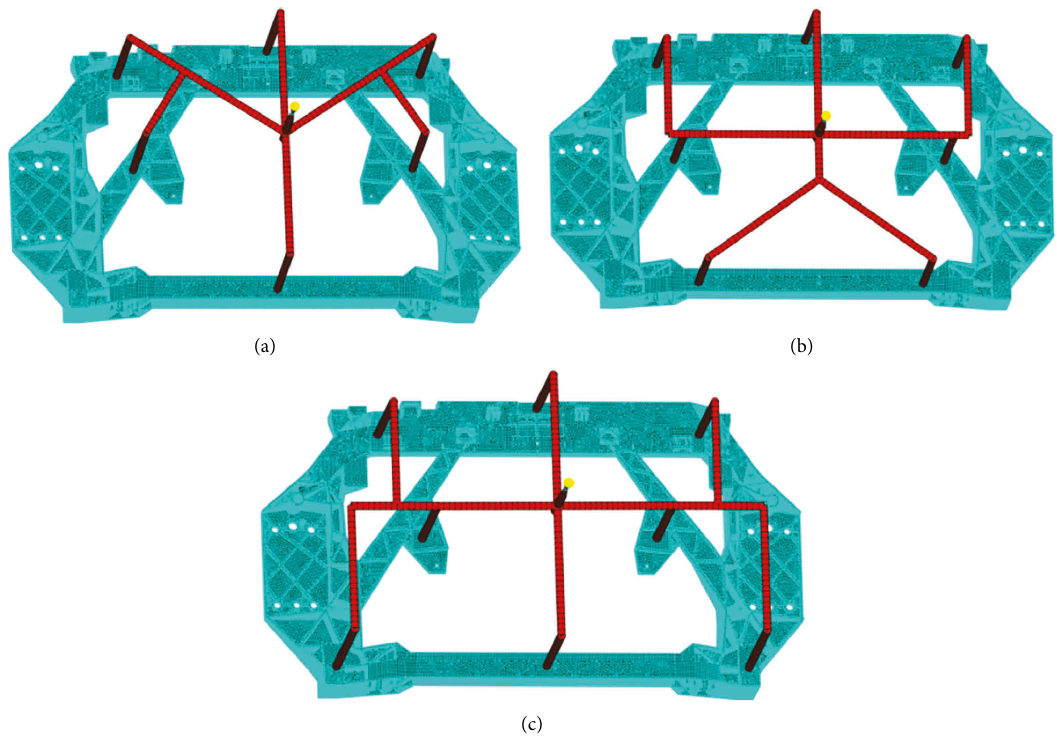
Figure 7: Gating system designed. (a) 6 gate gating systems. (b) 7 gate gating systems. (c) 8 gate gating